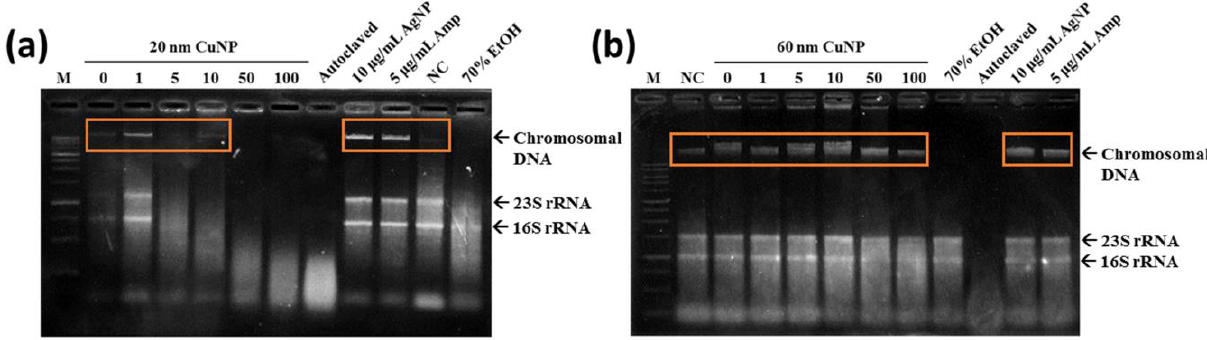
Figure 5. Total genomic DNA analysis of E. coli via electrophoresis. Chromosomal DNA damages were detected in bacteria treated with 20 nm CuNPs ( a ), or 60 nm CuNPs ( b ), in a series of concentrations (0, 1, 5, 10, 50, 100 µ g/mL) for 24 h followed by genomic DNA extraction. Ten µ g/mL AgNPs and 5 µ g/mL Amp were incubated with bacteria for 3 h to induce condensation of DNA and early apoptosis in E. coli . Autoclaving and 70% alcohol treatments were applied to induce acute cell death. PBS treatment was used as a negative control (NC) in the study of cell survival and chromosomal DNA integrity. One kb DNA ladder was loaded as the marker (M). The arrows indicated the positions of chromosomal DNA, 23S rRNA, and 16S rRNA. Orange frames marked the condensed DNA. DNAs were analyzed by agarose-based gel electrophoresis, and a Gel Doc EZ imaging system was used to obtain